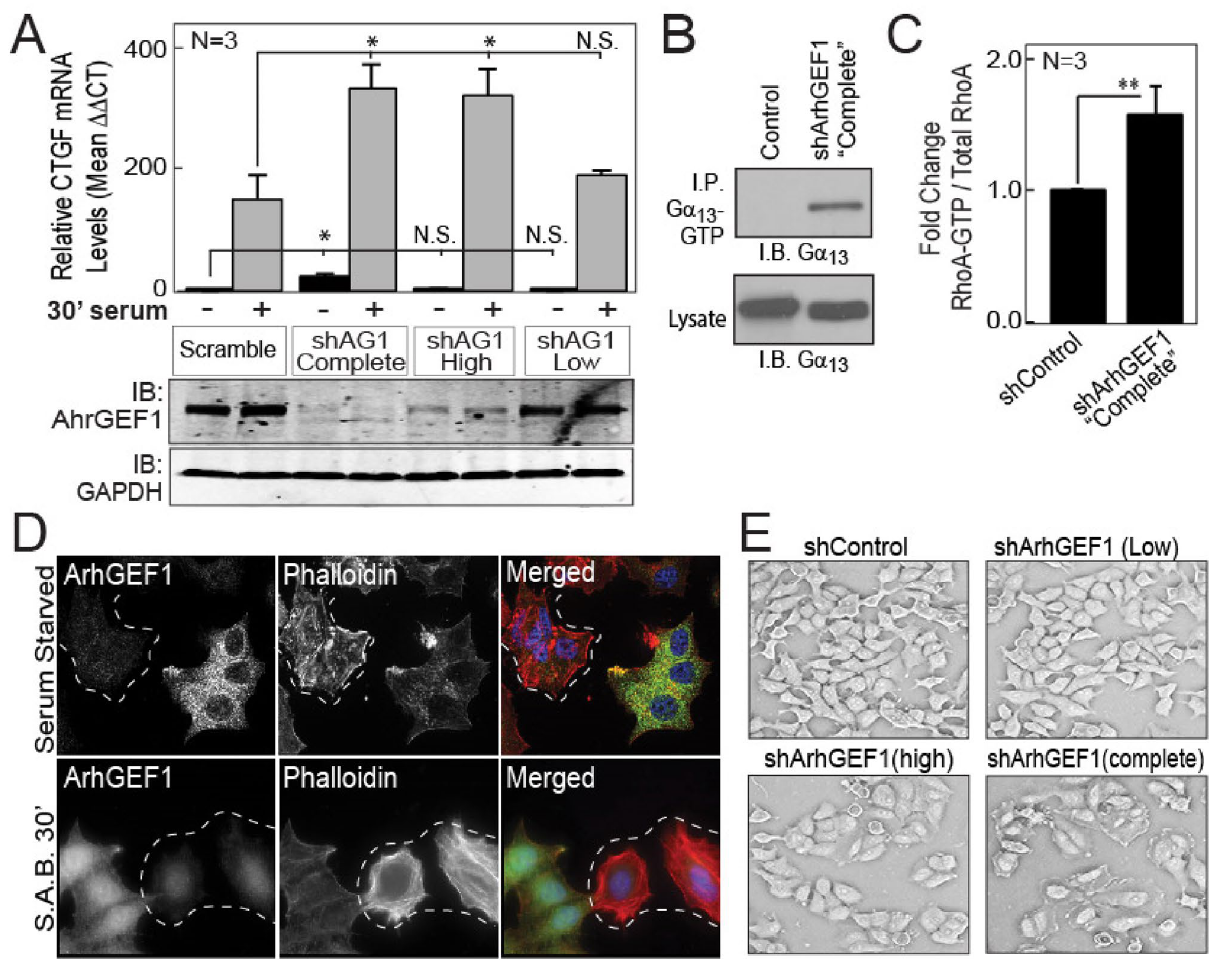
Figure 6. Complete ARHGEF1 silencing results in the basal activation of YAP1 and RhoA as well as enhanced actin fiber accumulation and cell flattening. ( A ) Serum Starved MCF7 cells with shcontrol, complete, high or low levels of ArhGEF1 (AG1) silencing were treated with 0 or 10% serum for 30 min. Fold-change in CTGF transcript levels were measured by qRT-PCR (top panel). Immunoblot analysis of ArhGEF1 and GAPDH levels of replicate samples (lower Panel). ( B ) Gα 13 -GTP was selectively immunoprecipitated with an anti-Gα 13 - GTP antibody from lysates from control and ArhGEF1 silenced cells. Gα 13 -GTP and total Gα 13 were detected by immunoblot analysis of lysates and immunoprecipitations. ( C ) Total and GTP bound RhoA levels were measured by G-LISA (Cytoskeleton Inc.) in lysates from control or complete ArhGEF1 silenced MCF7 cells. Mean ratios from three biologic replicates are presented. ( D ) Immunofluorescence images of MCF7 cells with high and low ArhGEF1 silencing that were serum starved for 24 h before treatment with 0% or 10% serum (S.A.B.) for 30 min. Cells were stained for ArhGEF1, Phalloidin to visualize actin and DAPI to see nuclei. Dotted lines demarcate clusters of cells with high levels of ArhGEF1 silencing. At right, merged images of ArhGEF1 (green), Phalloidin (Red), and nuclei (DAPI stain). ( E ) Brightfield images of the MCF7 cell pools described in A growing continuously in media with 10% serum. In C, **p-value of < 0.01 computed by student